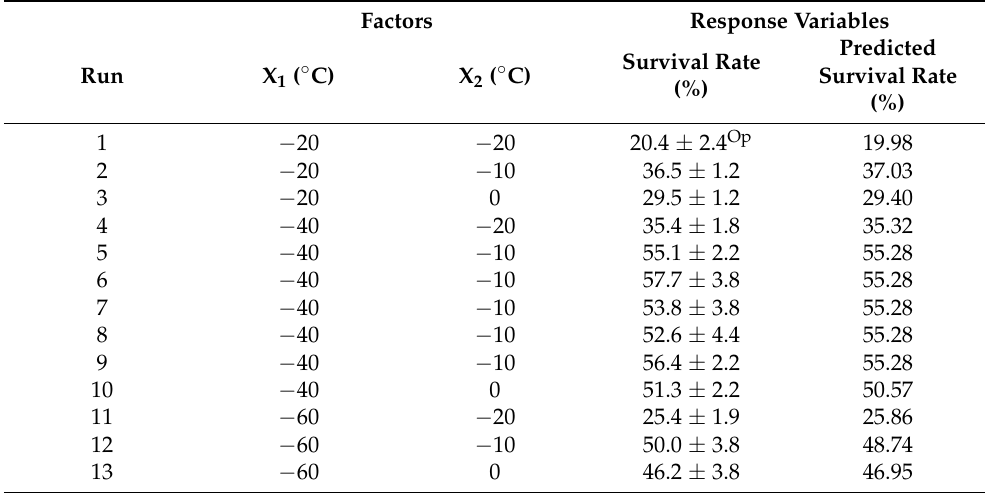
Table 1. Response surface methodology optimization designs of the effect of pre-freezing tempera- tures and sublimation temperatures on the survival rates of Bifidobacterium longum BB68S. Factors Response Variables Predicted Survival Rate Survival Run (%)